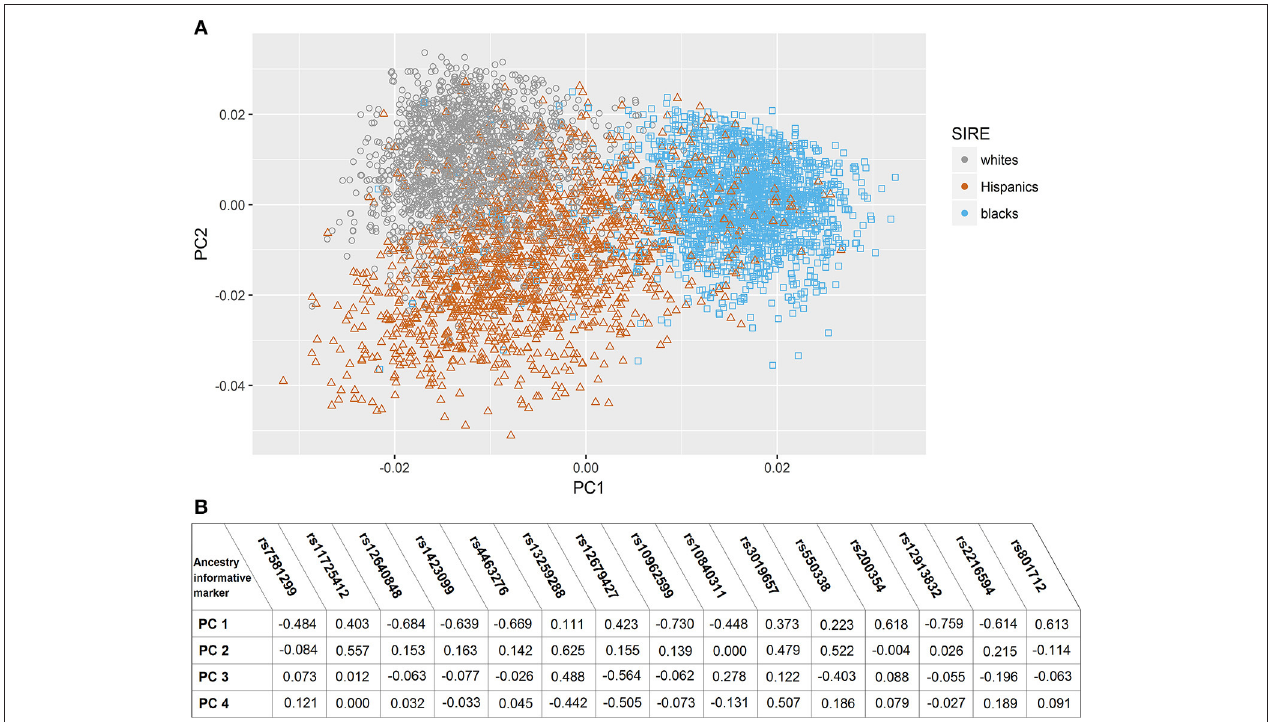
FIGURE 1 | Principal component analysis based on ancestry informative markers. (A) Scatter plot of subjects in Principal Component (PC) space, grouped by their self-identified race/ethnicity. (B) Correlation coefficients between eigenvactors (top 4) and the Ancestry informative markers selected genotypes.